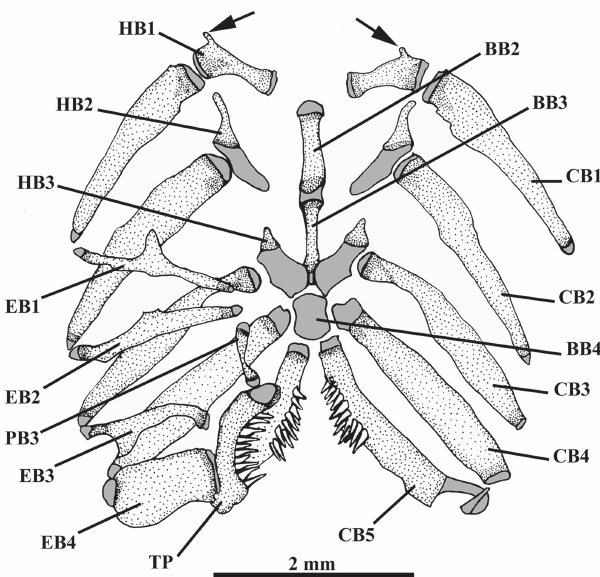
Fig. 2. Ituglanis inusitatus , new species, paratype, UFRGS 20201, 70.2 mm SL, c&s. Dorsal view of gill arches: basibranchials 2 to 4 (BB2-4), ceratobranchials 1 to 5 (CB1-5), epibranchials 1 to 4 (EB1-4), hypobranchials 1 to 3 (HB1-3), pharyngobranchial 3 (PB3), tooth plate attached to pharyngobranchial 4 (TP). Arrows indicate the process at distal portion of anterior margin of hypobranchial 1.